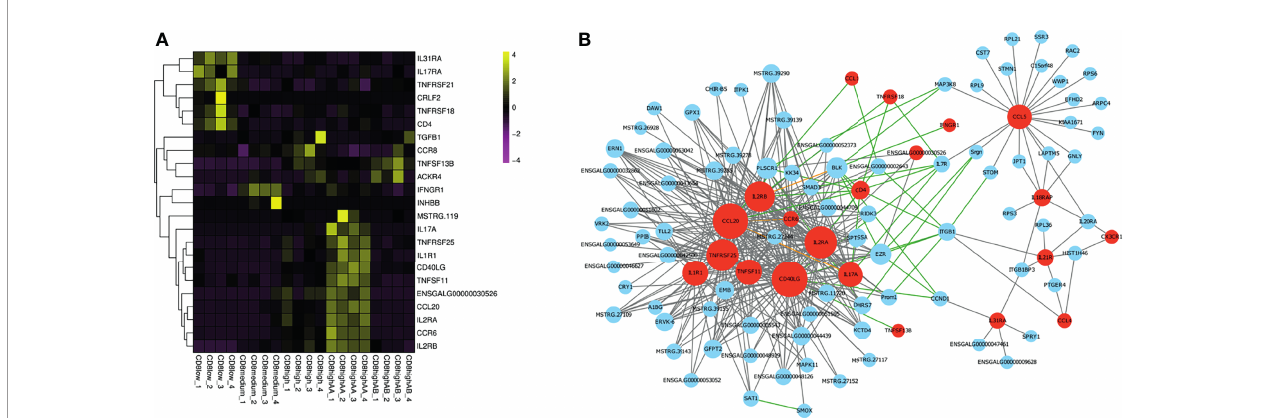
FIGURE 4 | Gene expression analysis enriched in the “ Cytokine – cytokine receptor interaction ” pathway of CD4 + CD8 low+ , CD8 medium+ , CD8 high+ , CD8 high aa +, and CD8 high ab + T cell populations. (A) Heat map of selected immune genes enriched in the “ Cytokine – cytokine receptor interaction ” pathway. (B) Gene interaction network analysis based on WGCNA analysis and STRING database. The gray line indicates the potential interaction relationship based on the WGCNA analysis. The green line indicates the potential interaction relationship based on the STRING database. The pink line indicates the potential interaction based on both the WGCNA analysis and STRING database. Red nodes represent hub